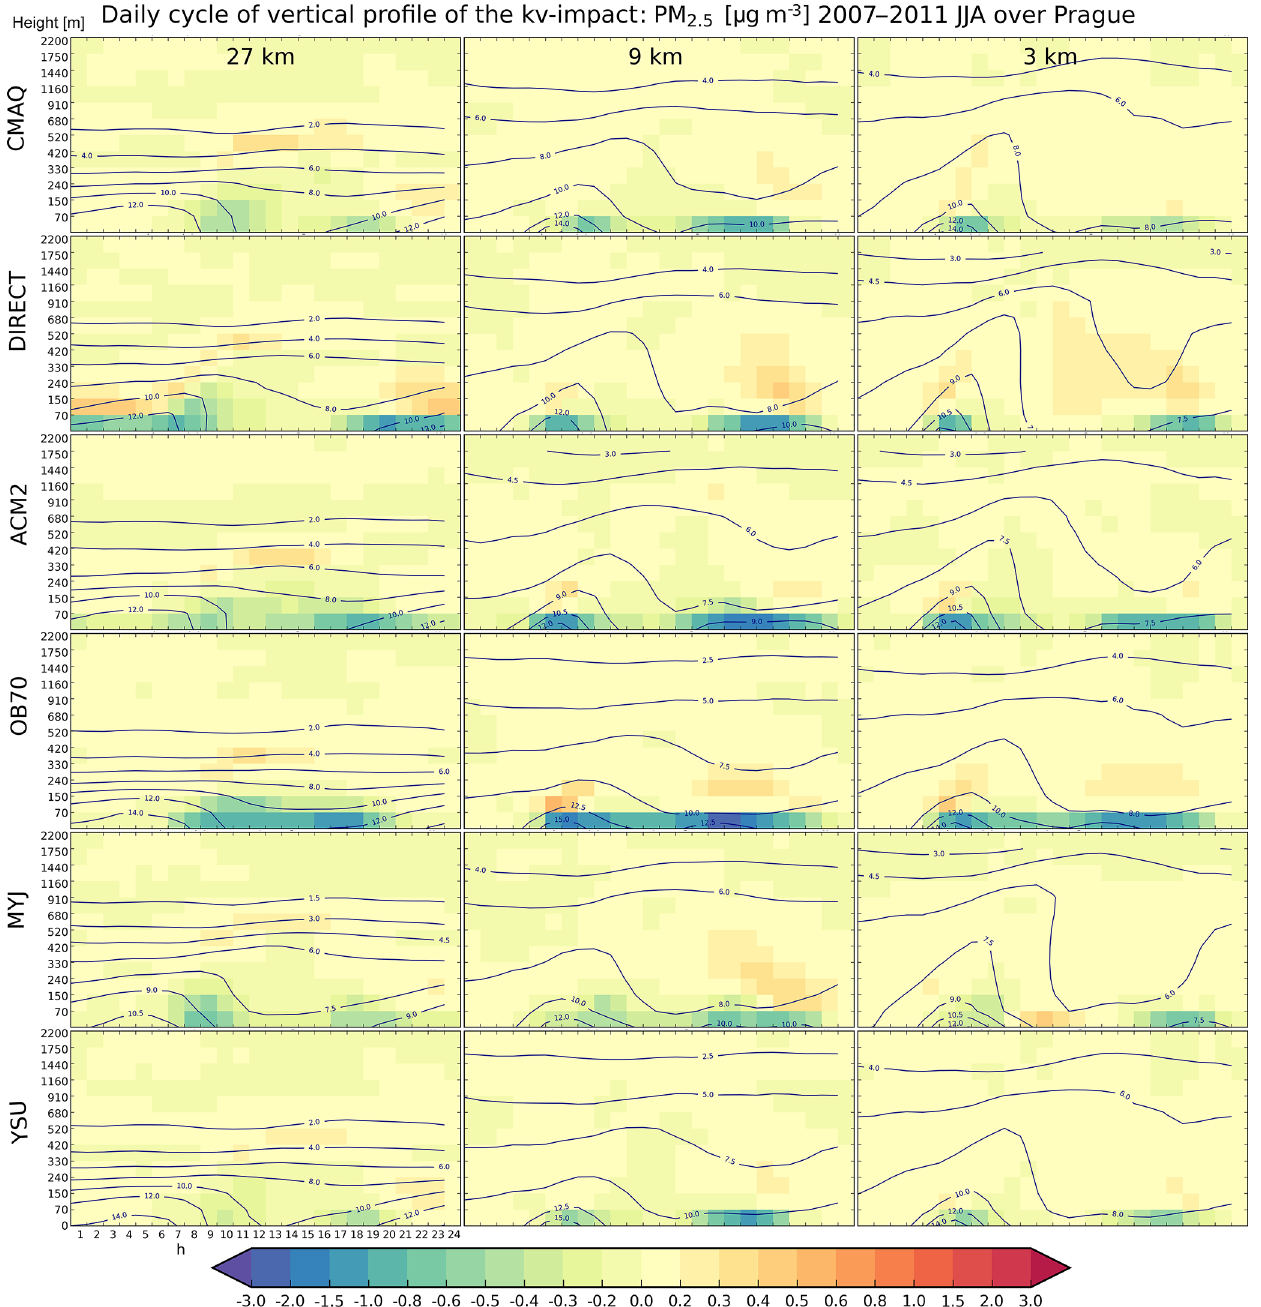
Figure 26. The impact of the urbanization-induced K v enhancement (i.e., increase of vertical eddy diffusivity) on the diurnal cycle of the PM 2 . 5 profile over Prague for JJA. Columns represent the three resolutions (27, 9 and 3km, from left to right). Rows correspond to individual K v methods. Colors indicate the difference; contours stand for the absolute concentrations (from the total-impact). Units are in µgm − 3